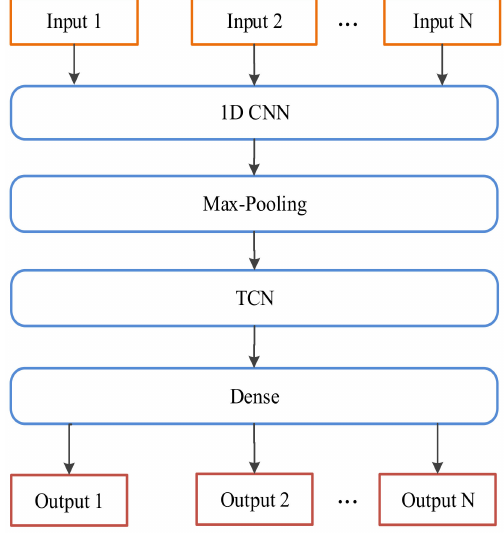
Figure 3. 1D-CNN-TCN network